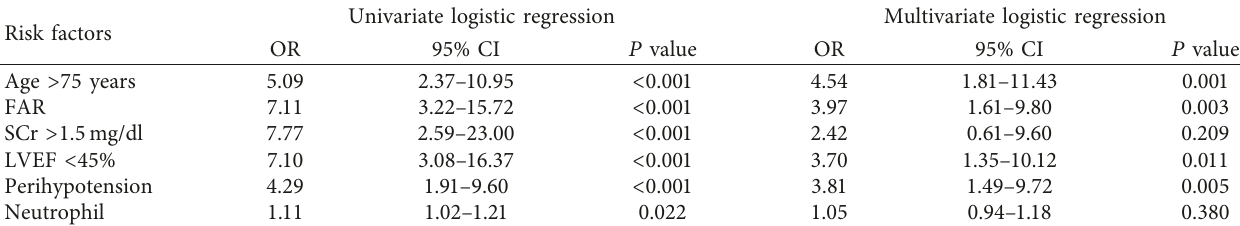
Table 2: Univariate and multivariate logistic regression analyses for